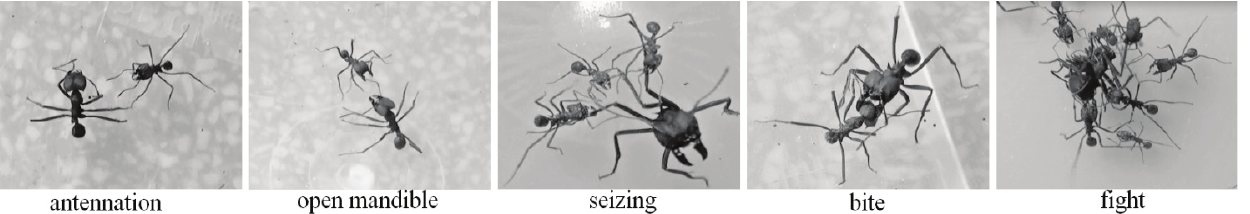
Figure 1. Behavioral acts registered during aggression assays using four Atta sexdens